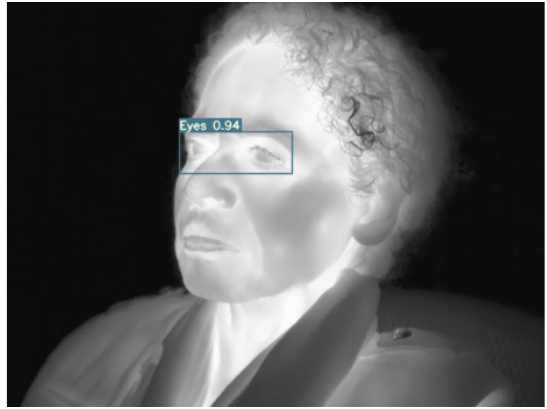
Figure 13. Detection of eyes in a senior face image using YOLOv7 elderly transferred model.